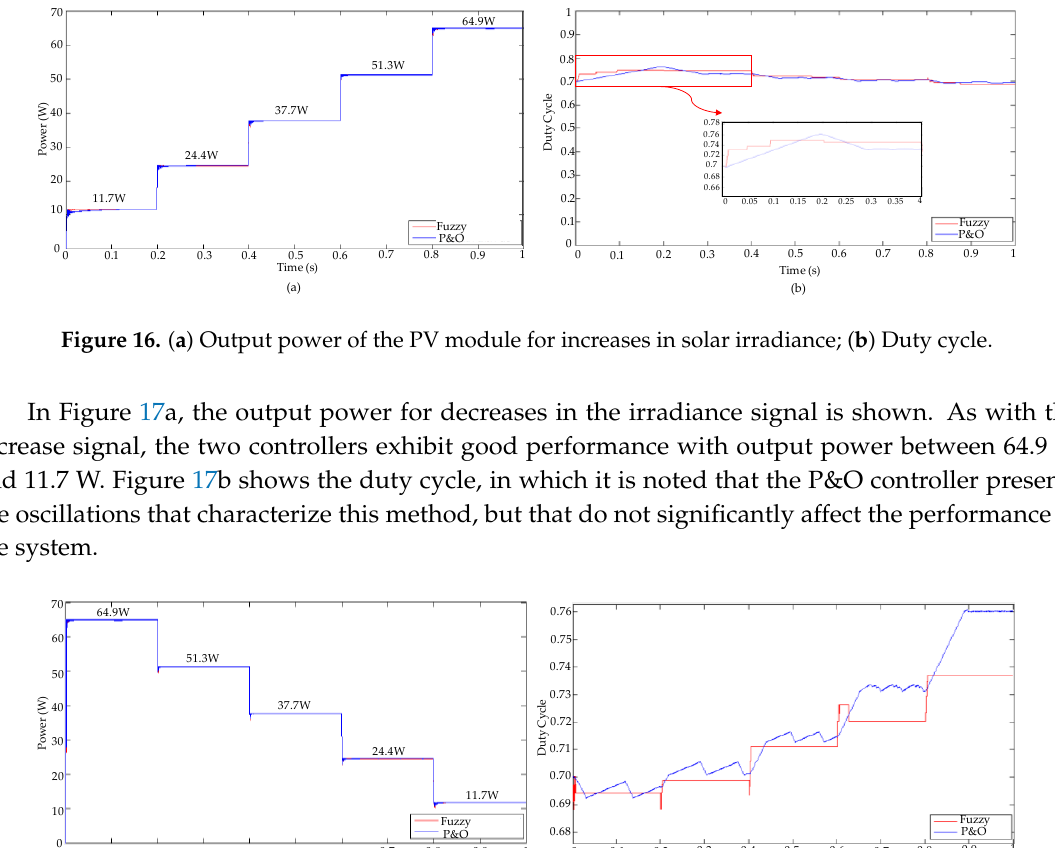
Figure 17. ( a ) Output power of the PV module for decreases in solar irradiance; ( b ) Duty cycle. With the tests carried out in case 2, it is evident that the two controllers exhibit a similar behavior for sudden changes in solar irradiance. In addition, it was found that the P&O control has small oscillations that do not significantly affect the power delivered to the battery. Case 3: changes in temperature, solar irradiance of 1000 W/m 2 At this point, the performance of the system was evaluated for sudden changes in temperature